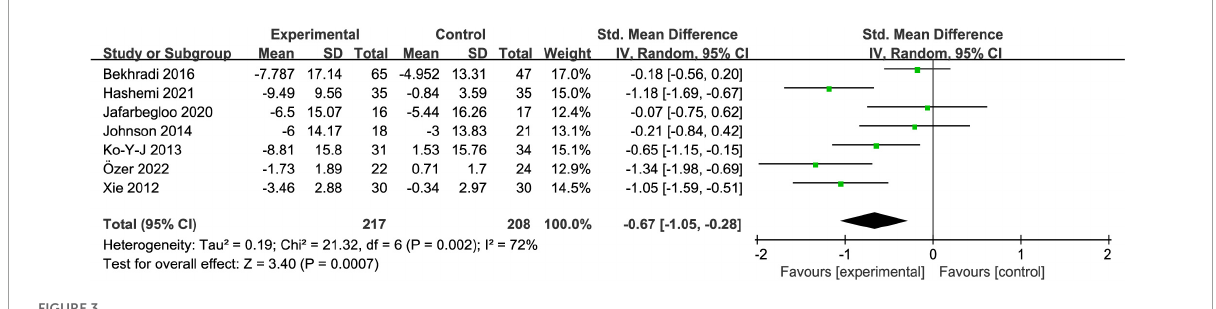
FIGURE3 The overall effect of aromatherapy on test anxiety in college students.